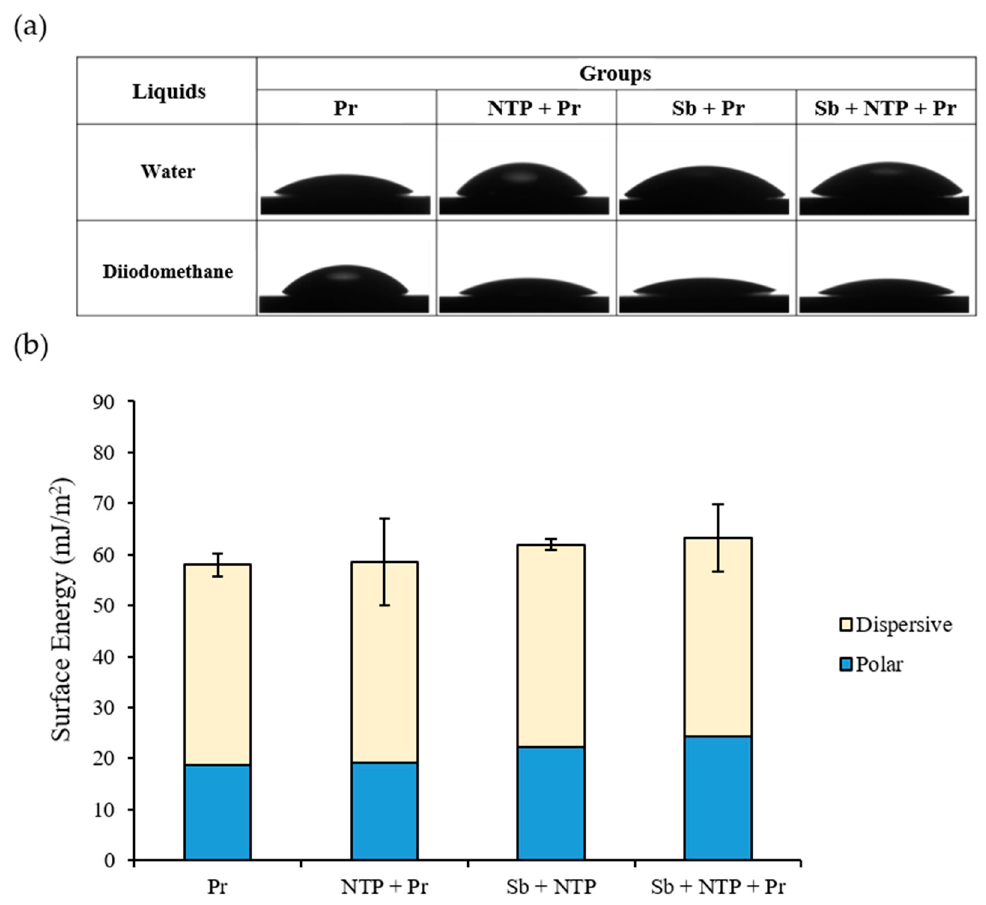
Figure 5. ( a ) Image of measuring contact angle of each group using water and diiodomethane. ( b ) Means of surface energy and its polar and dispersive part of each group. Pr, Zirconia primer; NTP + Pr, NTP + Zirconia primer; Sb + Pr, Sandblasting + Zirconia primer; Sb + NTP + Pr, Sandblasting + NTP + Zirconia primer.